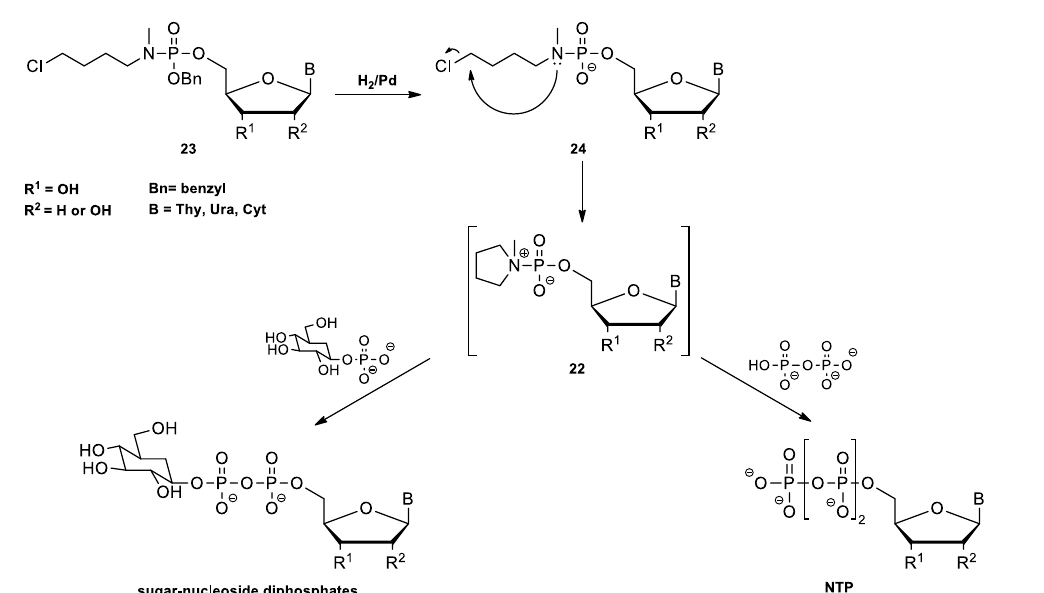
Scheme 15. Synthesis of NTPs via N -pyridiniumphosphonate intermediates of type 25